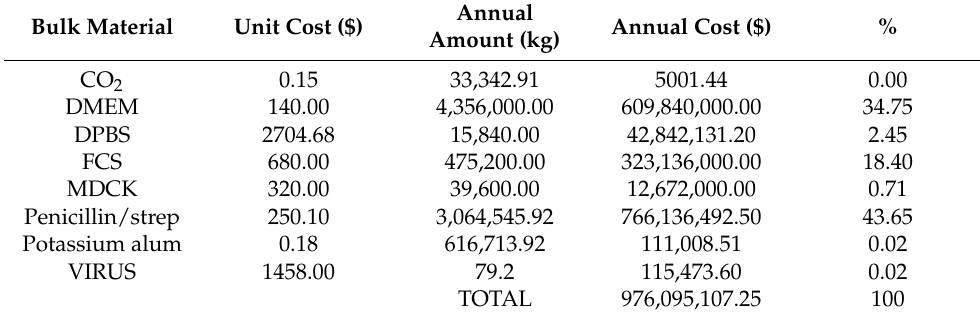
Table 5. Materials